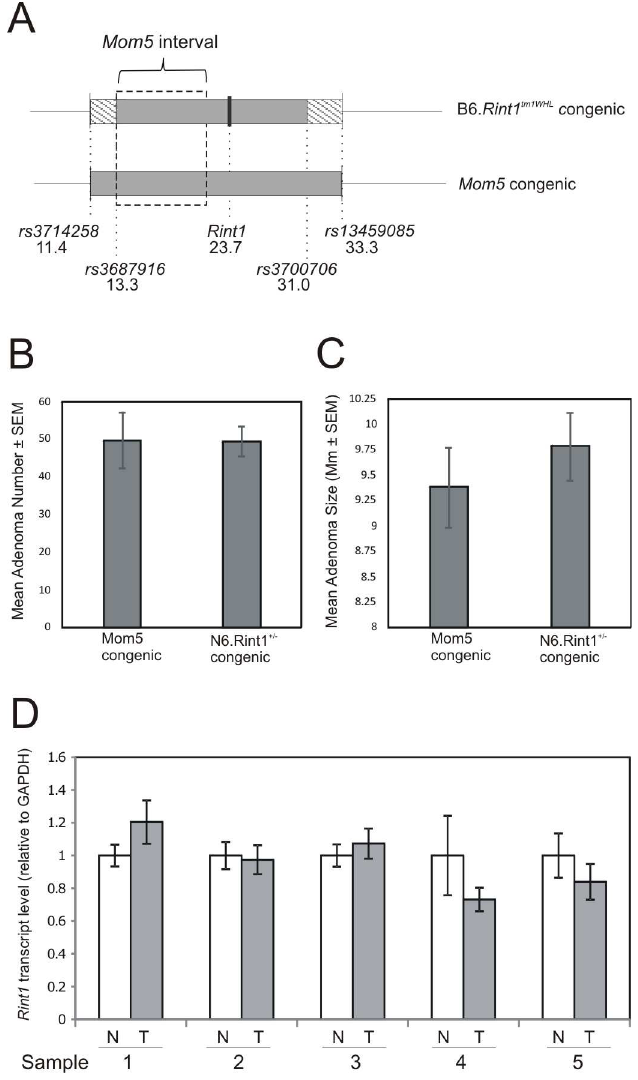
Fig 2. Loss of Rint1 and tumorigenesis in B6. Apc Min/+ mice. After marker assisted selection,the B6. Rint1 +/- strain was uniformly B6 except for a 21.9 Mbp interval of residualheterozygosity spanningthe Rint1 knockout allele(A). This regionincludesthe entire Mom5 modifier interval (A). Mean intestinal tumor number (B) in Rint1 +/+ ; Apc Min /+ mice (N = 25) and Rint1 +/- ; Apc Min /+ mice (N = 12) is shown. Mean diameter of intestinaltumors (C) in Rint1 +/+ ; Apc Min /+ and Rint1 +/- ; Apc Min /+ mice (N = 33–62tumors per mouse from N = 7 representative mice of each genotype)is shown. Analysis of Rint1 expressionin normalcolon and colon tumors (N = 5 pairs) in Apc Min /+ mice revealedno evidenceof loss of Rint1